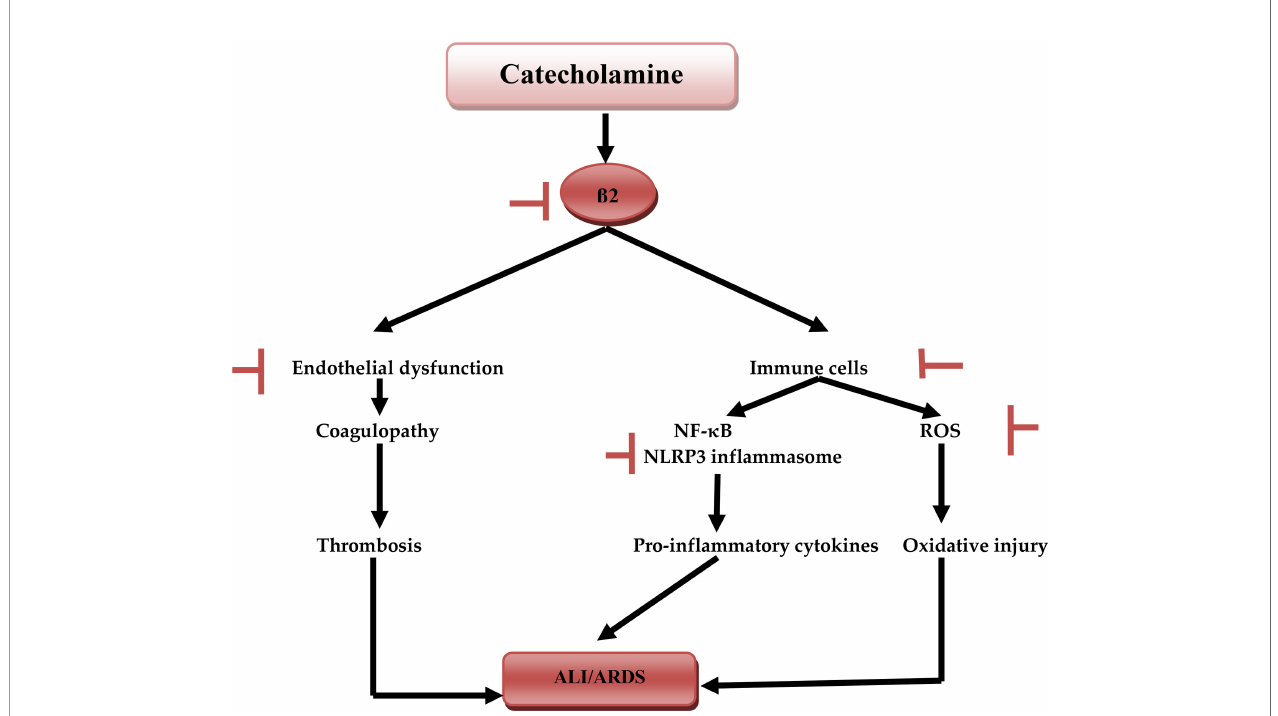
FIGURE 6 | Catecholamine and acute lung injury: catecholamine during SARS-CoV-2-induced sympathetic storm, activates b 1, which activates NF- k B and NLRP3 in fl ammasome of immune cells macrophages and neutrophils induces the release of pro-in fl ammatory cytokines. Activation of immune cells triggers the generation of reactive oxygen species (ROS), activation of b 2 leads to the development of endothelial dysfunction, coagulopathy, and thrombosis. Together these changes cause acute lung injury (ALI) and acute respiratory syndrome (ARDS). Inhibitory effects of b